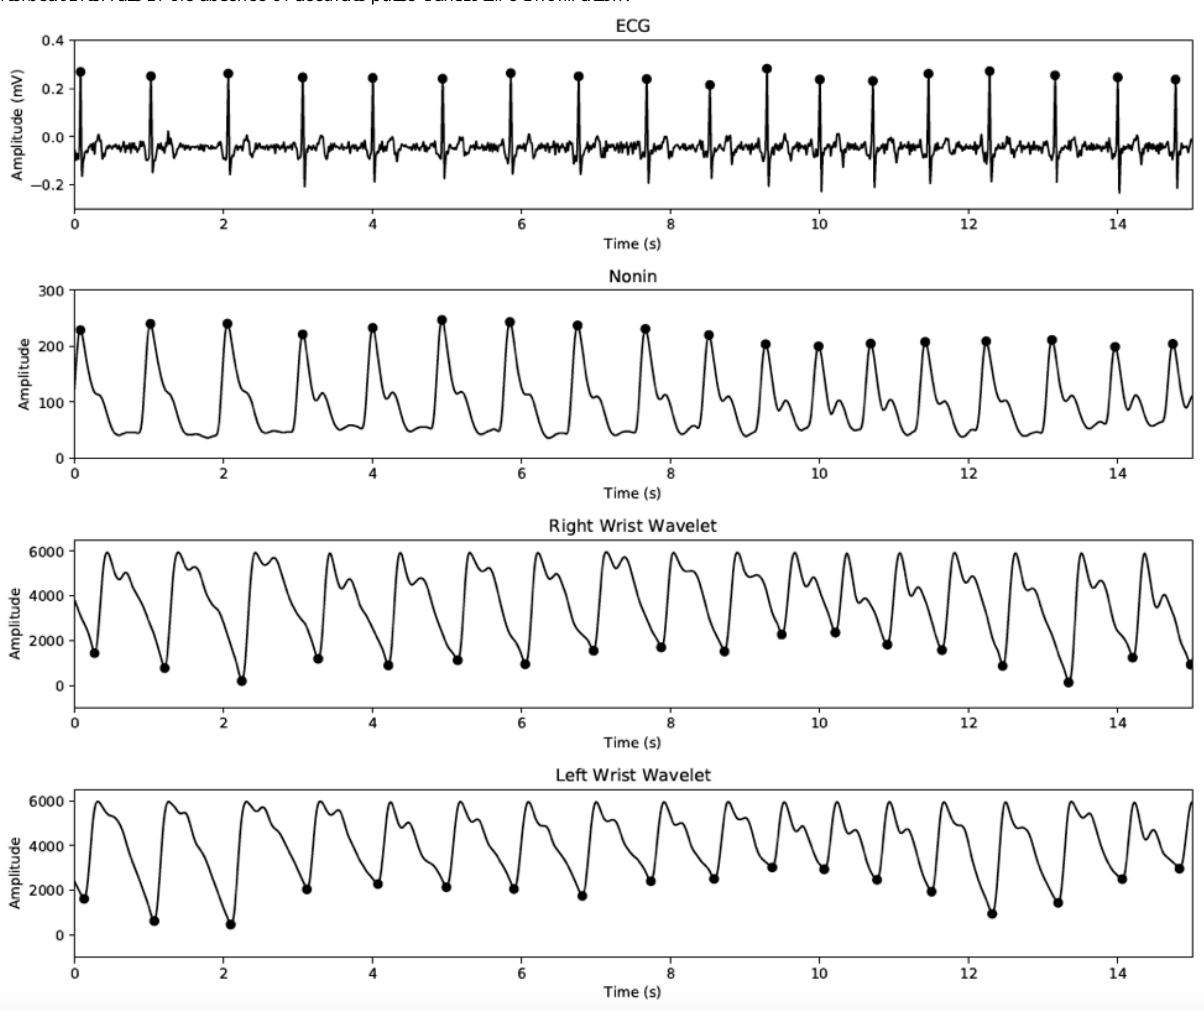
Figure 3. Signal traces recorded simultaneously from electrocardiography (ECG), Nonin finger-clip pulse oximetry device, and 2 Wavelet wristbands placed on the left and right wrists. Peaks (ECG and Nonin) or valleys (Wavelet) are marked. Signs were aligned based on time stamps and agreement of interbeat intervals in the absence of accurate pulse transit time